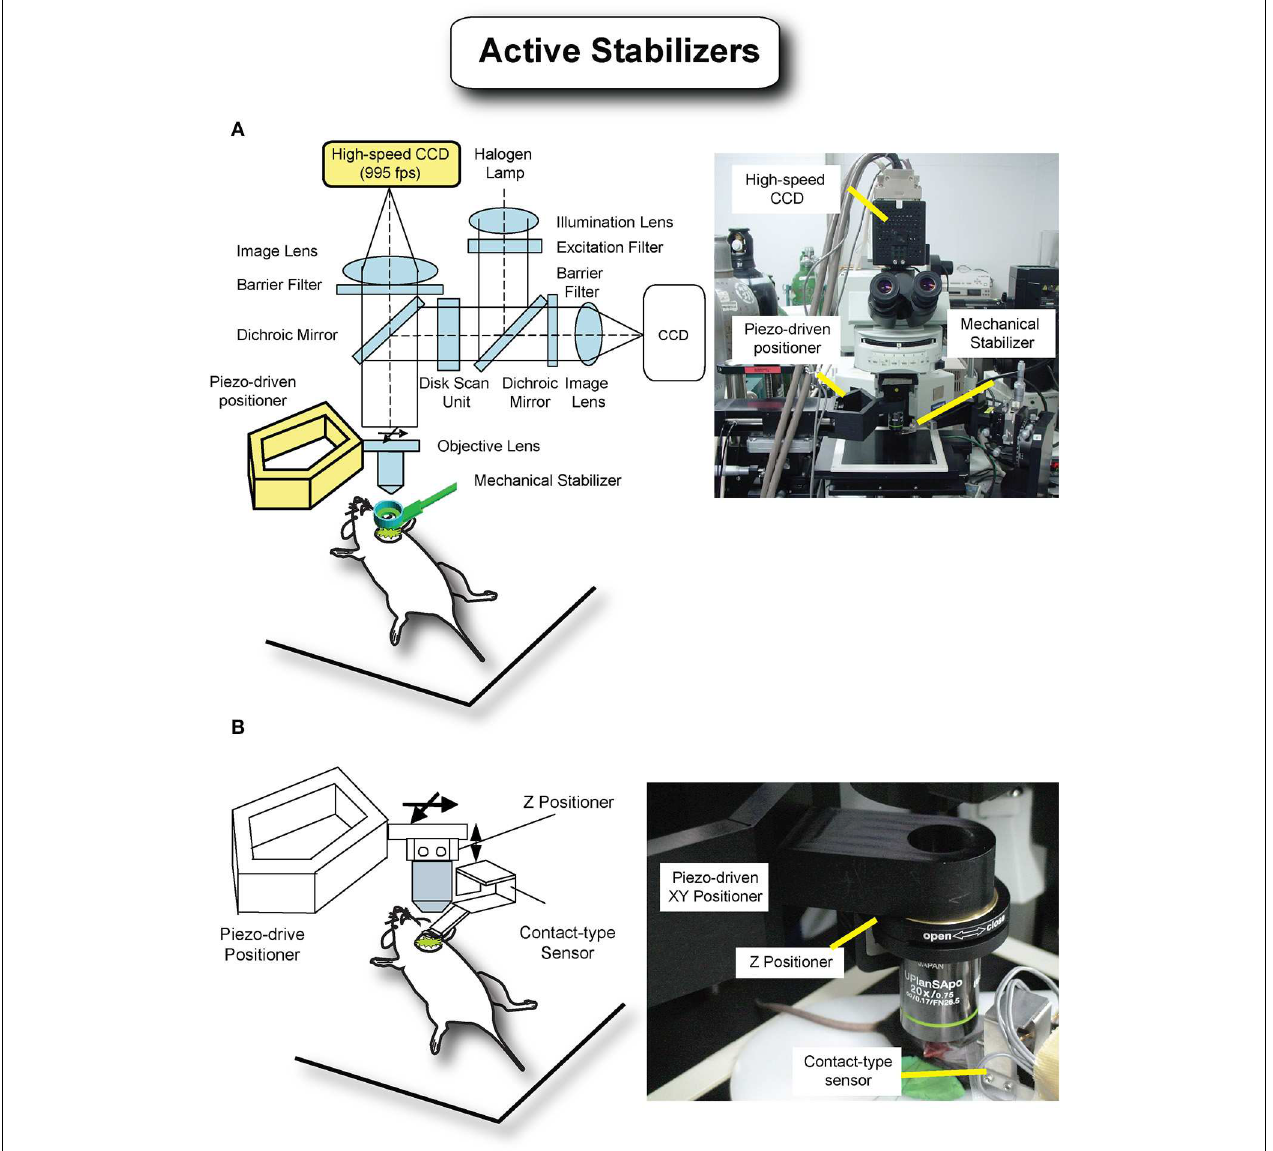
fast movement of the objective lens. Adapted from Lee et al. (2008). (B) A contact-type sensor consisting of three cantilevers beams with strain gauges was designed to measure the three dimensional movement of the tissue instead of the previous high-speed camera. This sensor also works as a passive stabilizer, reducing the movement with soft